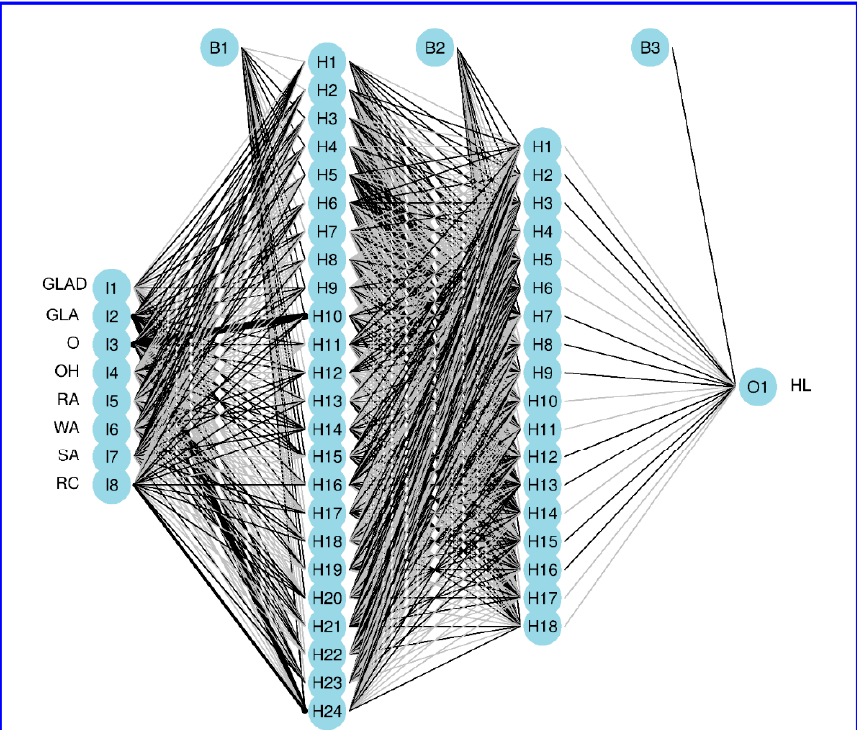
Figure 11. Structure of the PSO-ANN model for estimating HL of EEB systems.